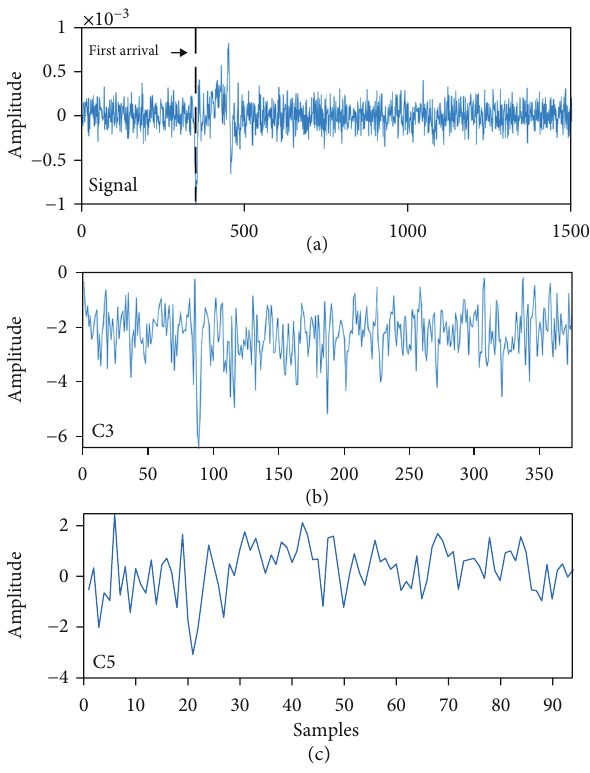
Figure 13: Forward modeling signal with -3-dB Gaussian noise added and its intermediate features extracted by the UNet++. (a) The forward modeling signal with -3-dB Gaussian noise added. (b) Intermediate features of the signal extracted by C3 layer. (c) Intermediate features of the signal extracted by C5 layer.